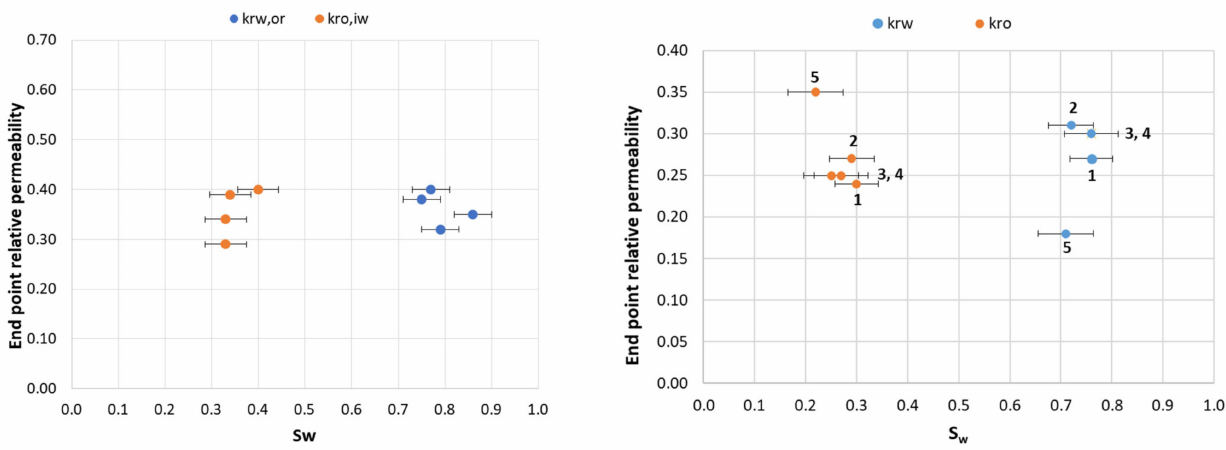
Figure 9. End-point relative permeabilities to water and oil as a function of water saturation for ( left ): LS11, LS14, LS17, and LS18 during the first Amott–Harvey cycle. ( right): development in end point relative permeabilities in core LS19 during five consecutive Amott–Harvey cycles. Note the y -axis